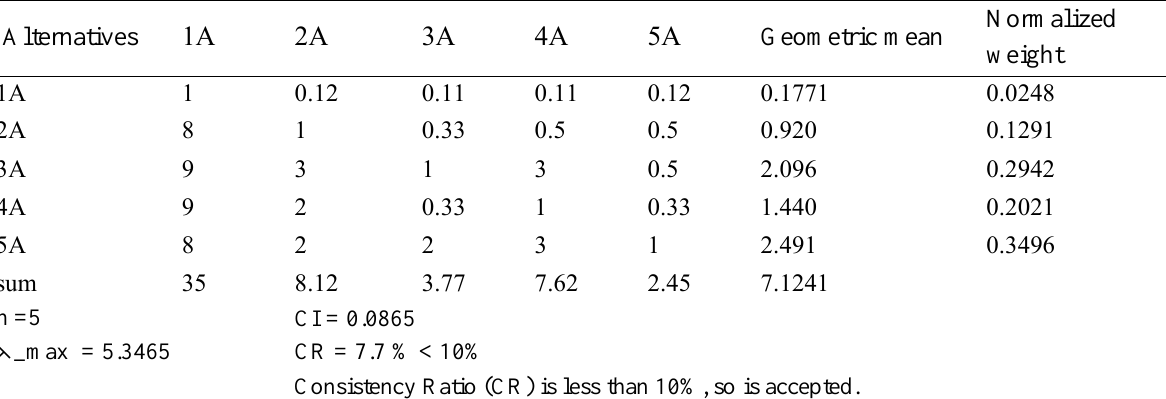
Table10. Comparison Matrix of Alternatives with respect to